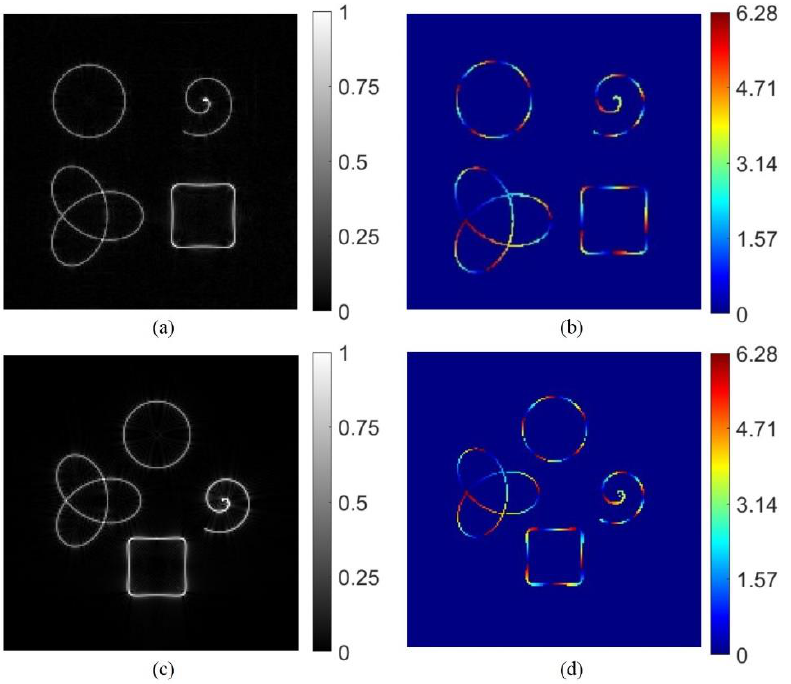
Figure 2. ( a , c ) Reconstructed intensity of the multiple light beams at the focal plane. ( b , d ) Phase Figure 2. Reconstructed intensity and phase distribution of the multiple light beams at the focal distribution of the multiple light beams at the focal plane.